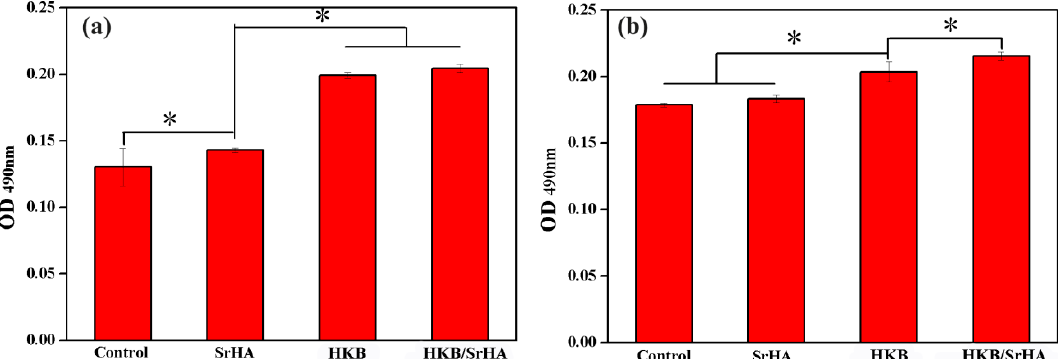
Figure 6. Proliferation of MC3T3-E1 cultured in each group for 3 and 7 days. (a) 3 days; (b) 7 days; ＊ p < 0.05.